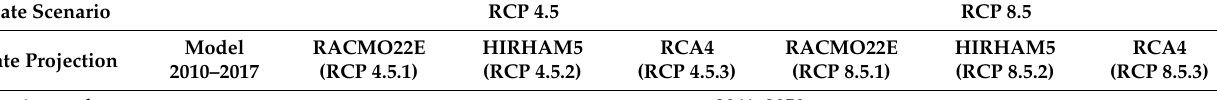
Table 5. Comparison of average soil water content by season for the SWAT 2010–2017 simulation period with climate projections (RCP 4.5.1, RCP 4.5.2, RCP 4.5.3, RCP 8.5.1, RCP 8.5.2, RCP 8.5.3) for the years 2041–2050 in the Bystra catchment. Bold numbers indicate soil water content, while shaded numbers indicate percentage change (red is % decrease in content; blue is % increase in content). Dark red and dark blue shading means large changes, while light red and light blue shading means small changes (own study).